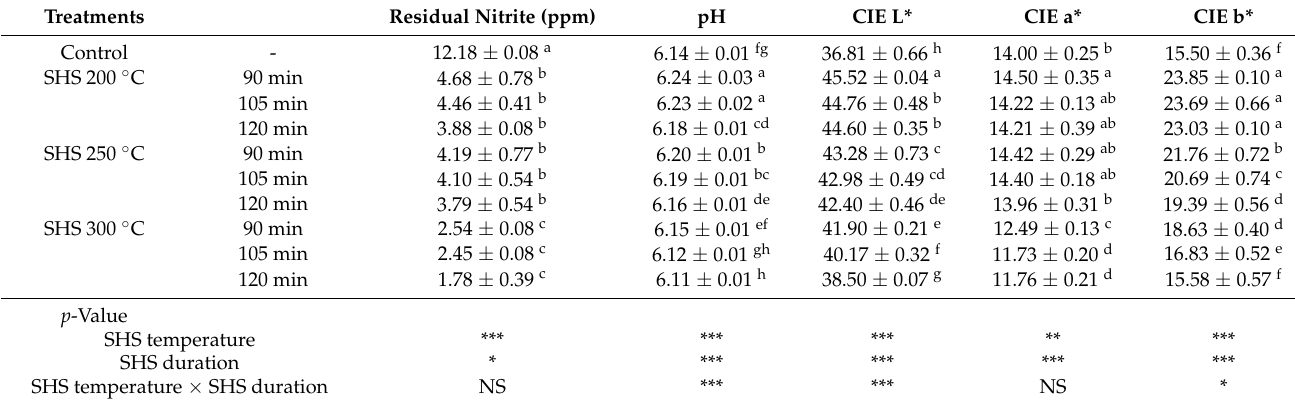
Table 2. Residual nitrite, pH, and color of semi-dried restructured jerky processed with super-heated steam (SHS). Treatments Residual Nitrite (ppm) pH CIE L* CIE a* CIE b*